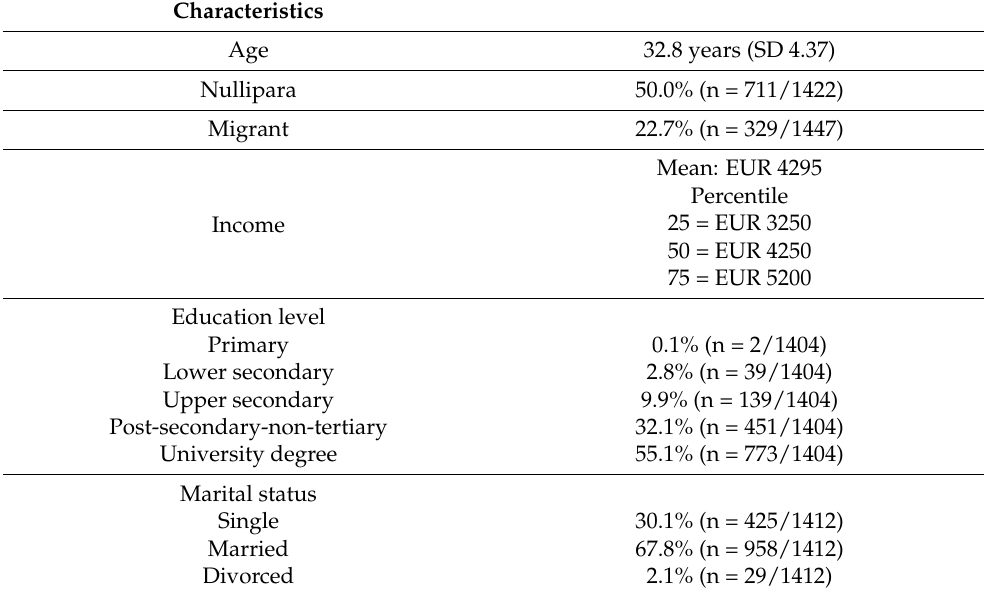
Table 2. Sample characteristics.